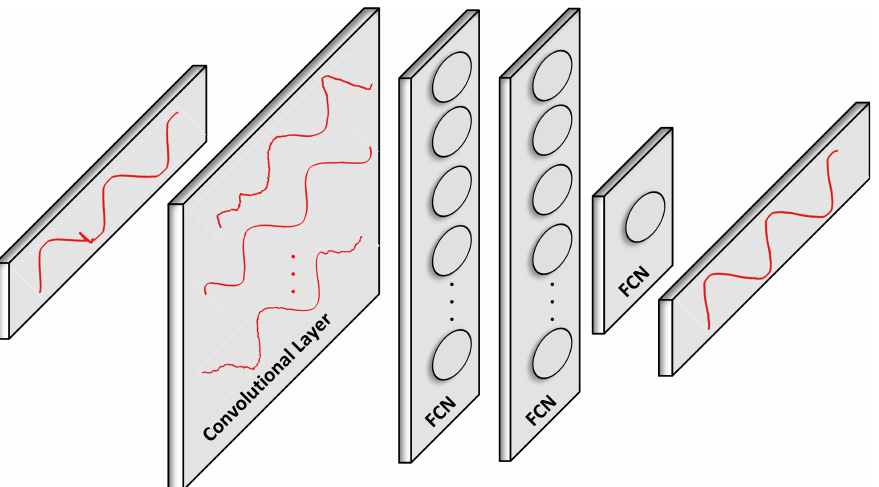
Figure 7. Internal topology of the 1D CNN that aims to extract the power grid voltage waveform without transients. This was then used to detect if a transient occurred by subtracting it from the input time series. The second network used the absolute difference to estimate the transient amplitude and duration.